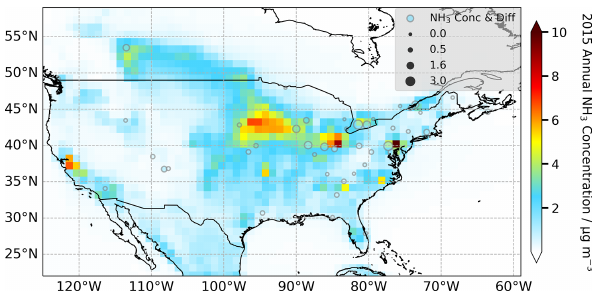
Figure 9. Modelled and measured 2015 annual mean NH 3 concen- trations in North America. Measurements are from the US AMoN Network and Canada NAPS Program. Monitoring sites are indi- cated by circles whose colour represents the measured concentra- tion and whose diameter (see inset legend) represents the absolute difference between model and